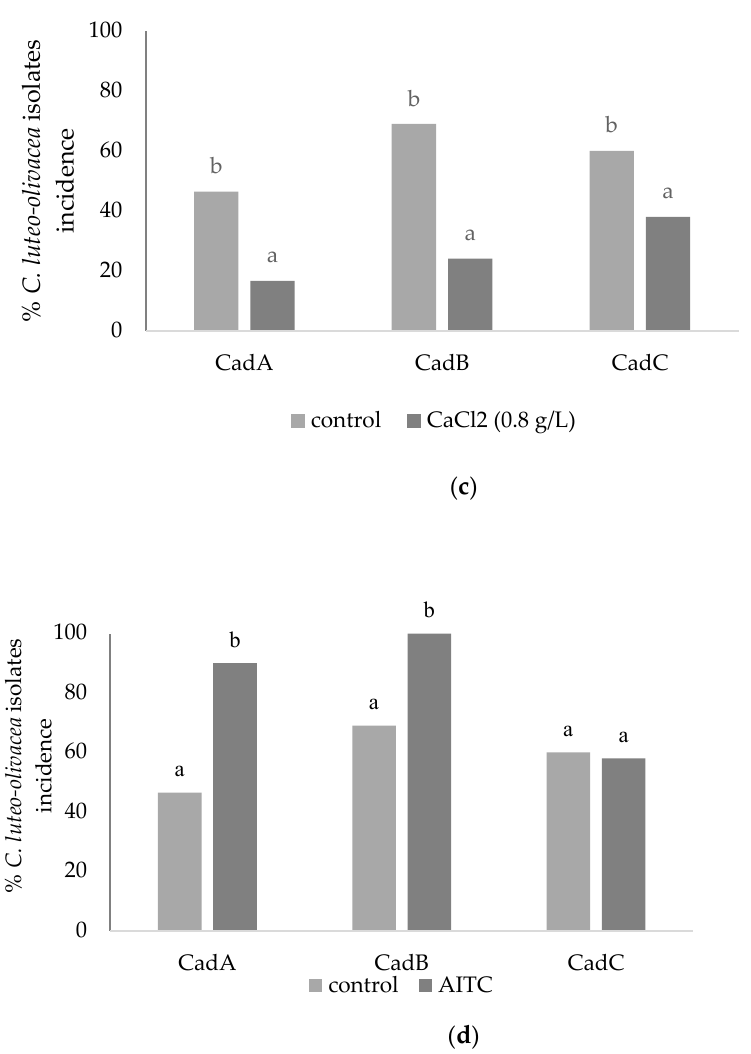
Figure 2. Kiwifruits treatments. ( a ) Antagonistic effect by Aureobasidium pullulans (L1 and L8) and Trichoderma harzianum (Th1) against Cadophora luteo-olivacea isolates (CadA, CadB, CadC). Kiwifruits were artificially inoculated with antagonists cells and conidia suspensions (20 µ L) (10 8 cells mL − 1 and 10 5 conidia mL − 1 , respectively) and after 1 h with C. luteo-olivacea isolates conidial suspension (20 µ L, 10 5 conidia mL − 1 ). ( b , c ) Effect of synthetic treatment (fludioxonil 1 g L − 1 ) and CaCl 2 (0.8 g L − 1 ) 1 min dipping on kiwifruit, suddenly artificially inoculated with C. luteo-olivacea isolates conidial suspension (20 µ L, 10 5 conidia mL − 1 ). ( d ) Kiwifruits, artificially inoculated with C. luteo-olivacea isolates conidial suspension (20 µ L, 10 5 conidia mL − 1 ) and bio fumigated with B. nigra defatted meal (10 g, 30 mL of SDW) inside a storage cabinet (0.1 m 3 ) for 24 h at 0 °C. Fruits were incubated for 5 months at 0 °C and 90% RH. Fruit inoculated with water and not biofumigated were considered as control treatment. Each value is the mean of three replicates (75 fruits) ± standard deviation. According to Tukey’s HSD Test, different letters represent significant differences within the treatments among the fungal isolates ( α = 0.05).